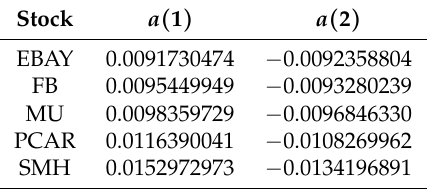
Table 3. a ( X k ) for